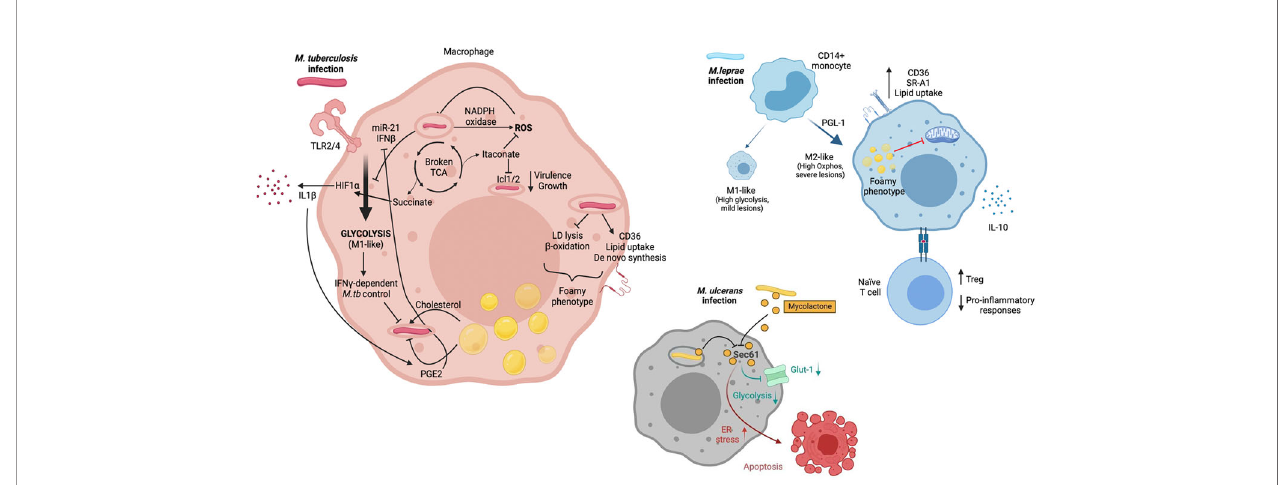
FIGURE 1 | M.tb , M.leprae and M.ulcerans infect macrophages and alter their metabolism. M.tb is primarily sensed by host macrophages through TLR2 and TLR4. Macrophage metabolism shifts towards glycolysis (M1-like), which allows infection control. M.tb has developed strategies to counteract this metabolic switch though induction of miR-21 and IFN b . M1-like macrophages present a broken TCA cycle, with elevated succinate concentrations that stabilise HIF1 a , essential for induction of glycolysis and secretion of pro-in fl ammatory cytokines such as IL-1 b . Itaconate also arises as a consequence of a broken TCA cycle and has multiple immune- regulatory functions, including inhibition of isocitrate lyases Icl1/2 . M.tb infection triggers ROS production through NAPDH oxidase. It also promotes increased intracellular lipid content. This results in the development of lipid droplets and the foamy macrophage phenotype, which can be bene fi cial (i.e. providing cholesterol as nutrient) or detrimental (i.e. secretion of prostaglandins) for the pathogen. M.leprae infection of CD14+ monocytes drives macrophages towards an M2-like phenotype, with a key role for PGL-1. M2-like macrophages rely on oxidative metabolism and are associated with severe lesions. Upon M.leprae infection, macrophages upregulate CD36 and SR-A1 which translates in increased lipid uptake. Lipid droplets and the foamy phenotype have been linked to suppressed mitochondrial function. Furthermore, M.leprae -infected macrophages promote a Treg phenotype when interacting with naïve T cells, together with an impairment of pro-in fl ammatory cytokine release. Mycolactone released by phagocytozed and extracellular M. ulcerans bacilli diffuses into the cytoplasm of host macrophages and neighboring cells, respectively, gains access to the Sec61 translocon and blocks its activity. An immediate effect of Sec61 blockade by mycolactone is the downregulation of secretory and transmembrane proteins, among which the glucose importer Glut-1, likely resulting in decreased glycolysis. Sustained Sec61 blockade in mycolactone-exposed cells, including macrophages, triggers ER stress responses culminating in apoptosis. Created with